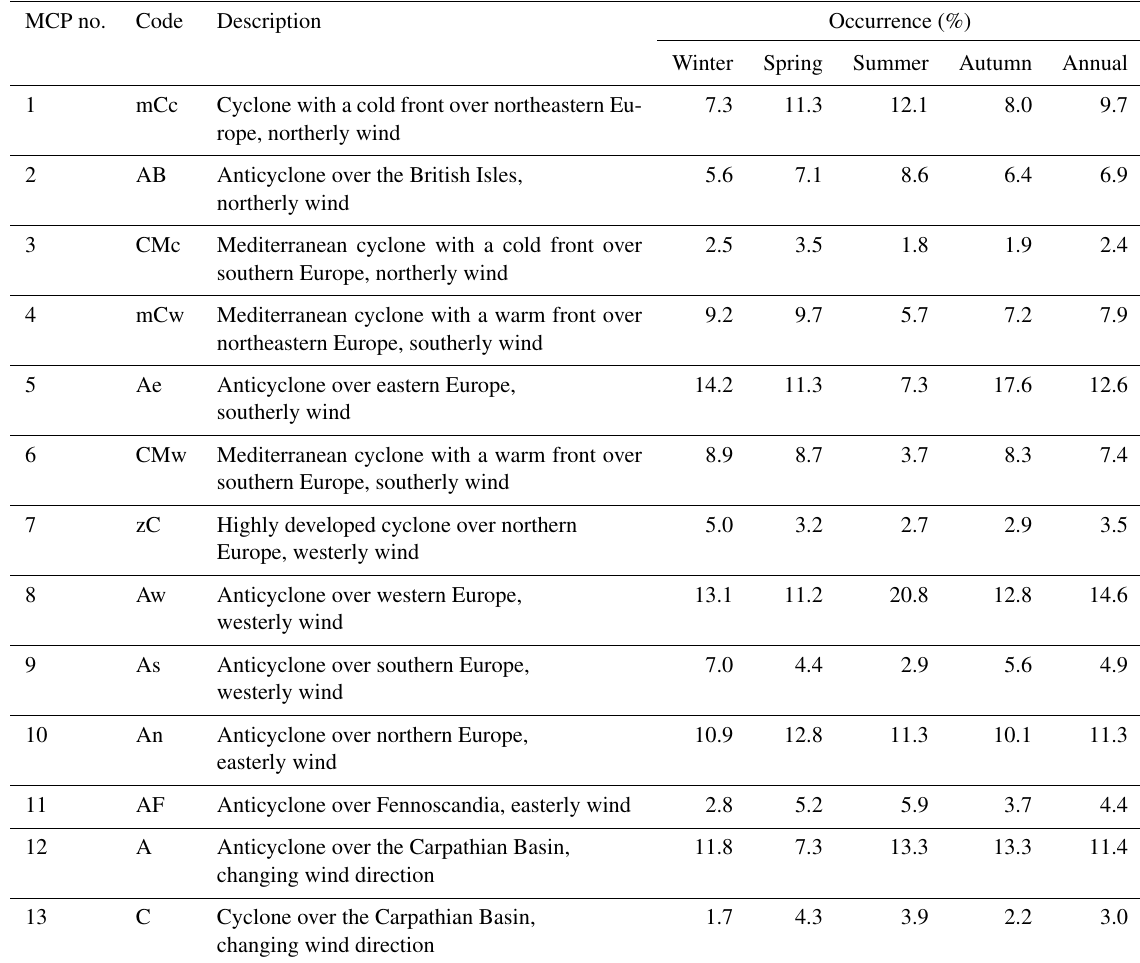
Table 1. Macro-circulation patterns (MCPs, Péczely codes) and their seasonal and annual occurrences in the Carpathian Basin for years 1958–2010 (Maheras et al., 2018). MCP